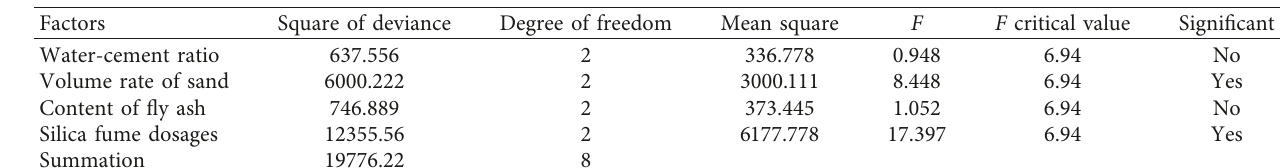
Figure 7: Test results of mechanical properties (density). Table 5: Analysis of variance (slump).